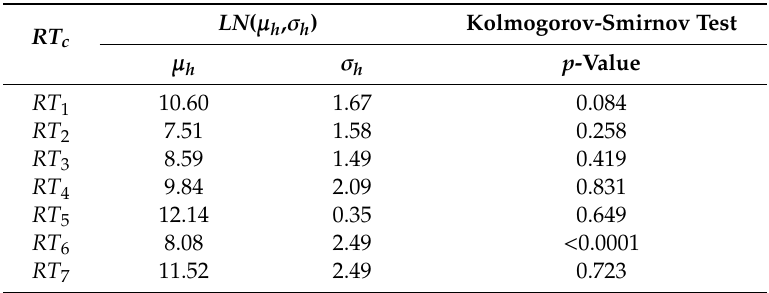
Table 6. Estimation and adjustment test of the LN ( µ h , σ h ) by risk